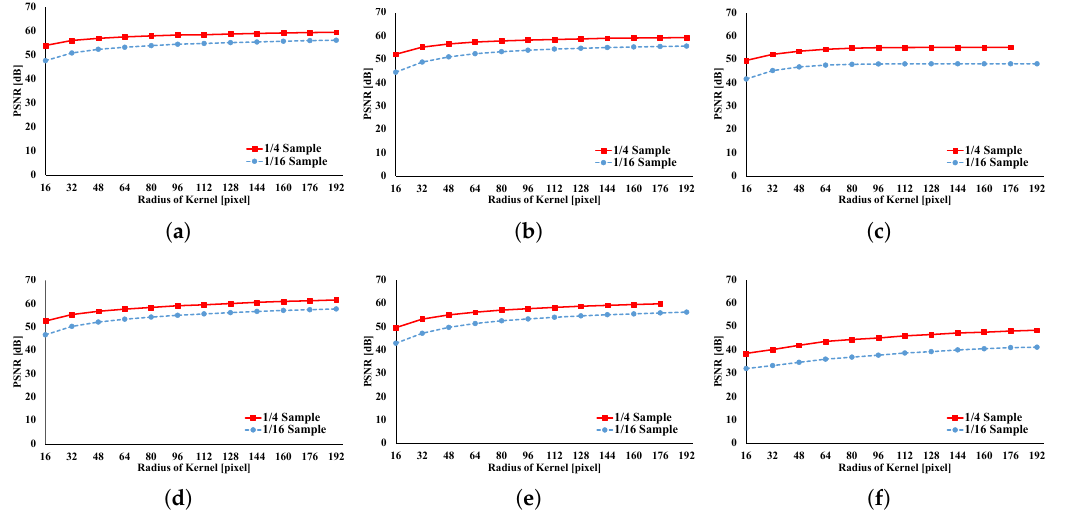
Figure 20. PSNR with respect to kernel radius of FIR filtering. ( a ) Gaussian range filter; ( b ) Bilateral filter; ( c ) Adaptive Gaussian filter; ( d ) Randomly-kernel-subsampled Gaussian range filter; ( e ) Randomly-kernel-subsampled filter; ( f ) Randomly-kernel-subsampled adaptive Gaussian filter. Image size is 512 × 512.